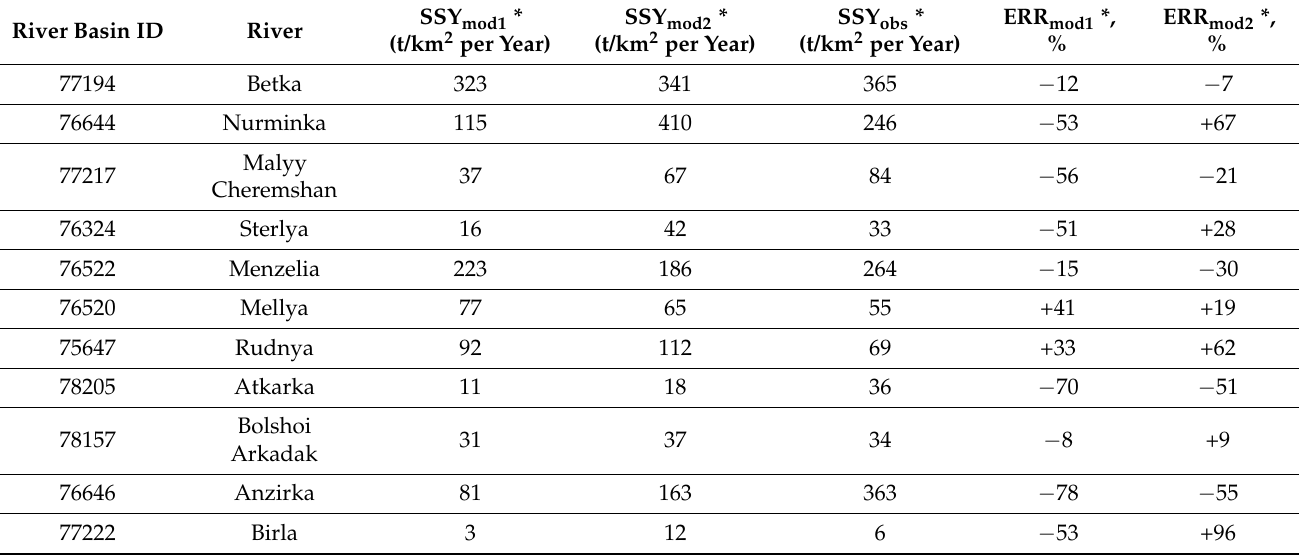
Table 7. Results of modeling and comparison with observed data on sediment